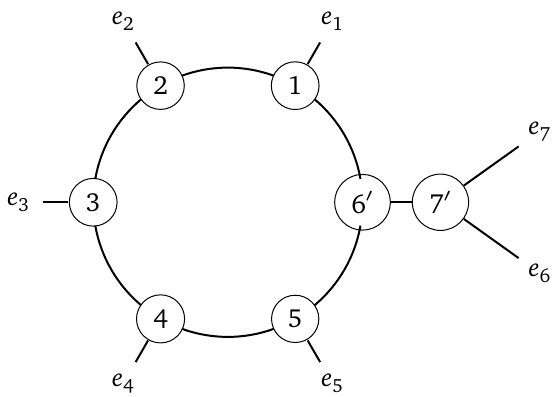
Figure 15: The tensor network in Figure 9 is shown after one unravelling stage, such that e and e are no longer held by tensors in the cycle. Note that all of the tensors 6 7 in this network are still rank 3.